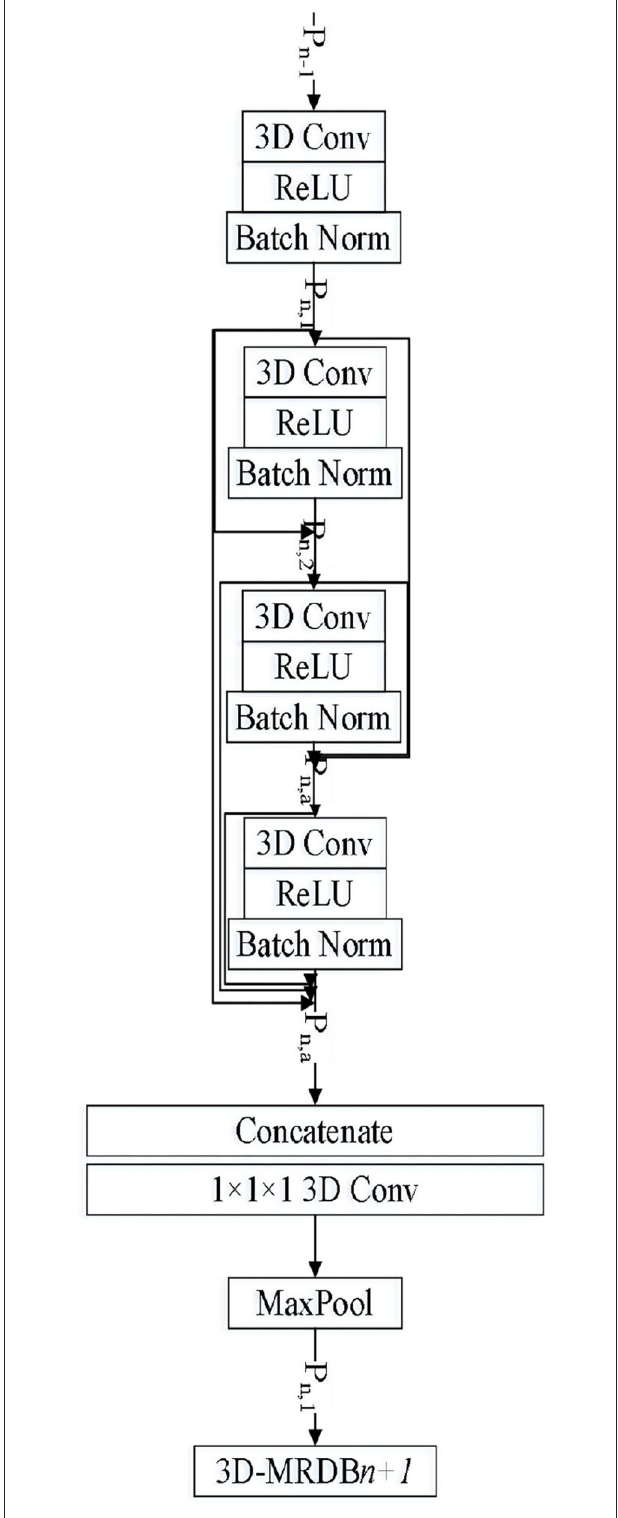
FIGURE 2 | 3-D residual sense